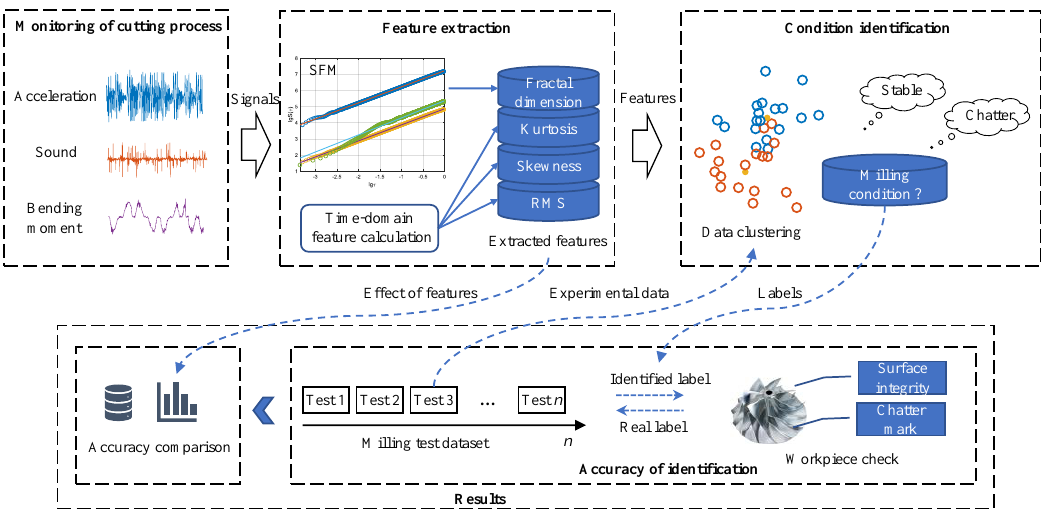
Figure 1. Proposed method.